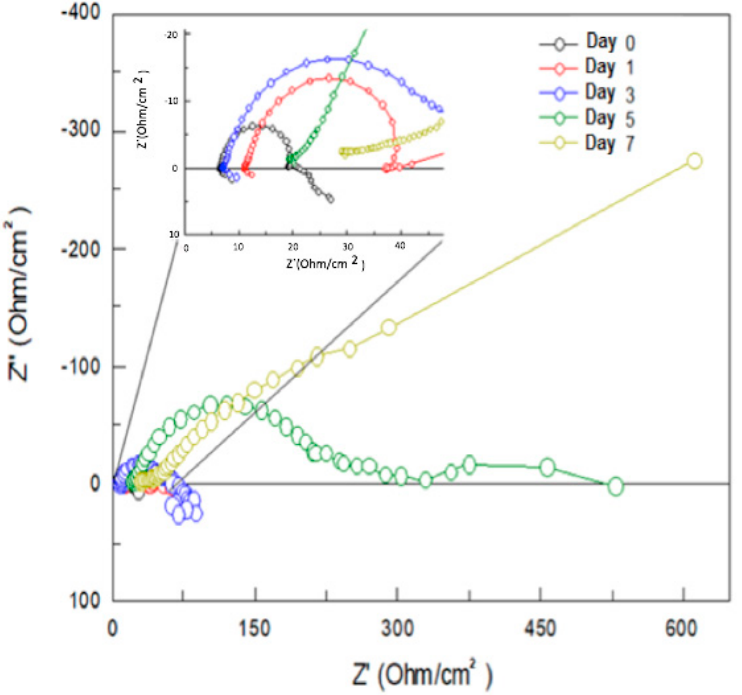
Figure 9. Nyquist diagrams for pure ‐ Mg anode for 0, 1, 3, 5, and 7 days of immersion in seawater. Figures 9–11 show the Nyquist diagrams for monitoring of the anodes of Mg, Mg-1Cr, and Mg-1Nb, respectively, for immersion times of 0, 1, 3, 5, and 7 days. The three anodes studied had similar behavior only differentiated by the magnitude of the impedance